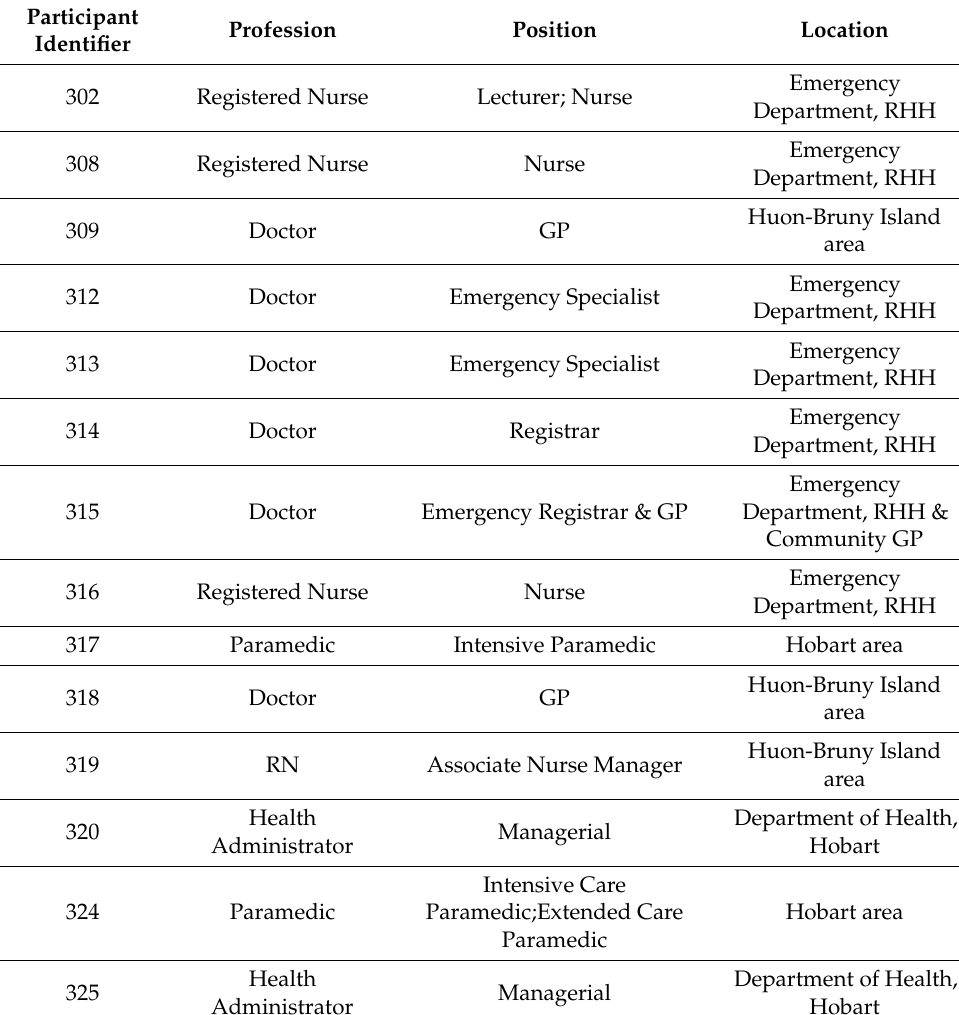
Table A1. Healthcare provider interviewee